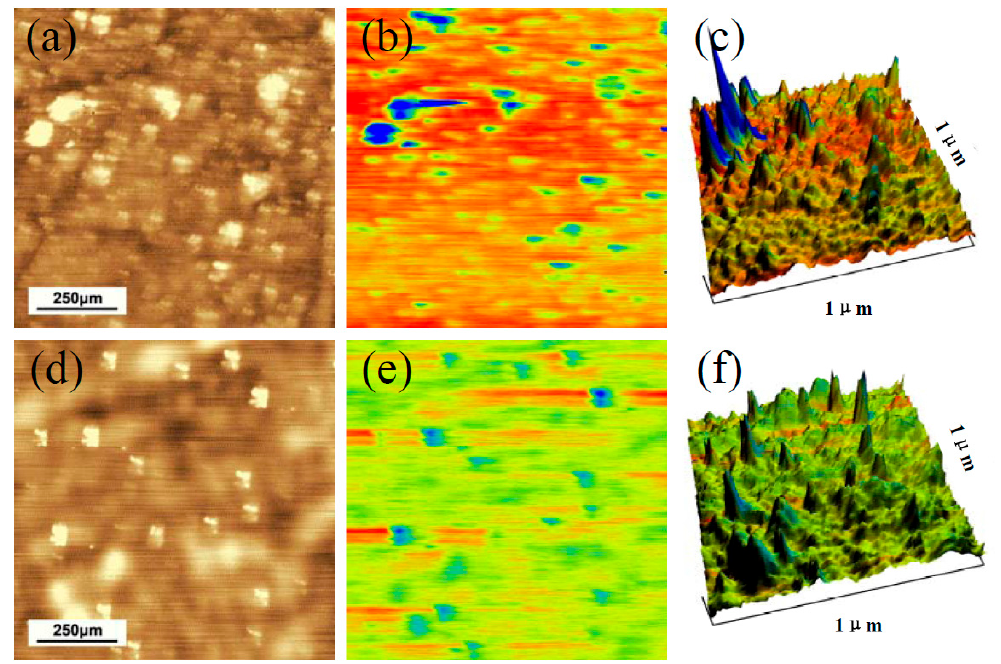
Figure 6. Surface nanoscale morphology for a typical microchannel wall of reduced lead silicate glasses. ( a , d ) AFM tomography, ( b , e ) KFM surface potential tomography and ( c , f ) 3D-mixed tomography.